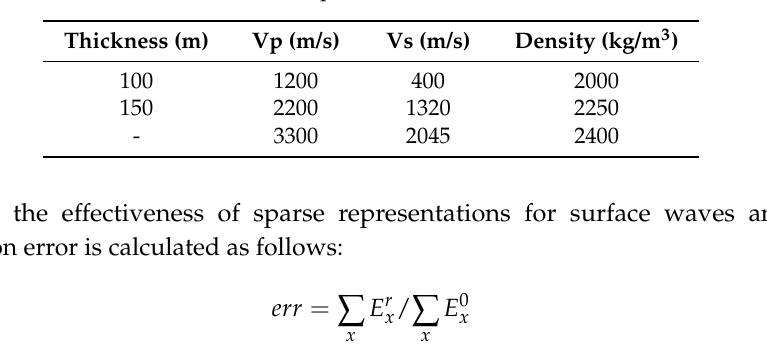
Figure 2. Synthetic reflections of Model 2. Table 2. The parameters of Model